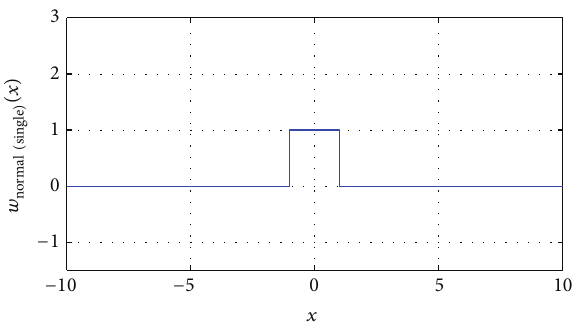
Figure 8: Applied